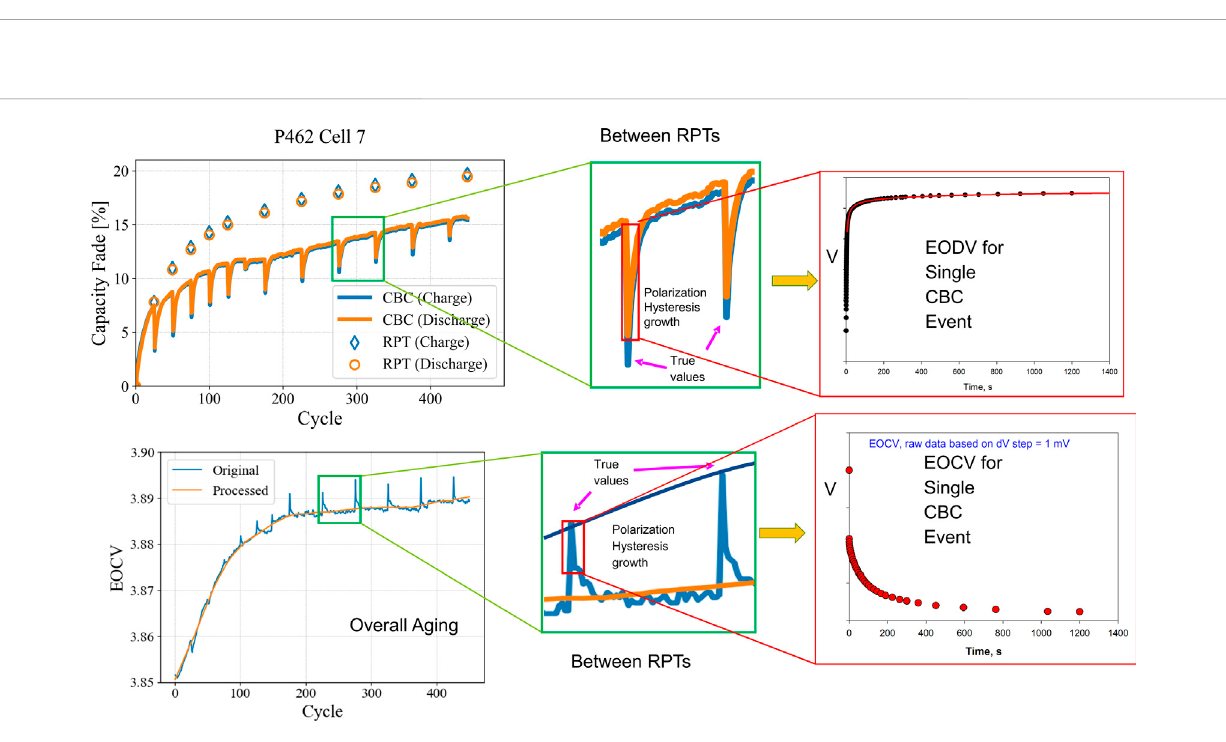
Dissection of CBC battery aging data for NMC/Gr cells, identifying the progression of PH between RPT intervals. Examples of individual EODV and EOCV are given, each spanning a 20-min